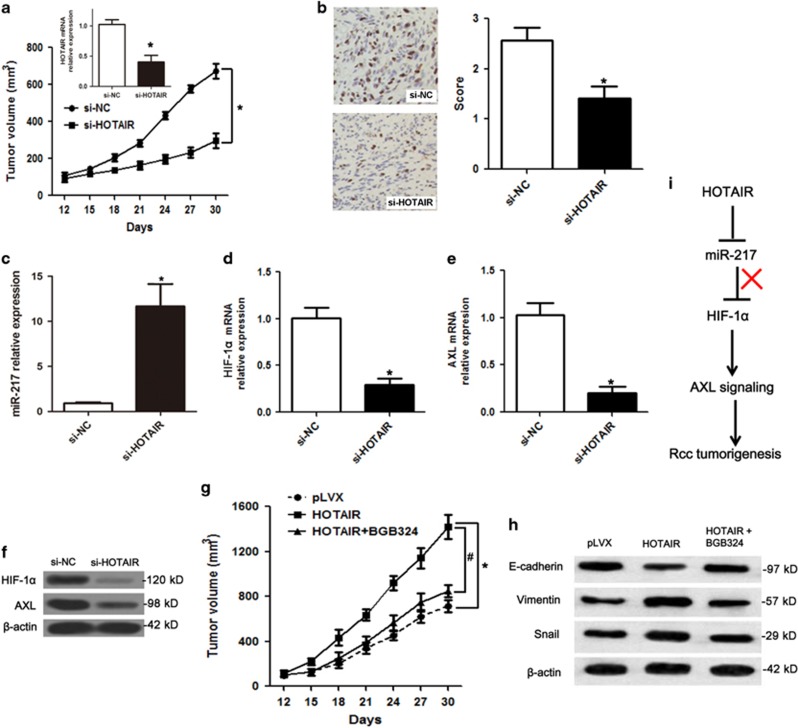
HOTAIR promotes Rcc cell growth via AXL signaling in vivo. (a) Tumor volume was evaluated for 12–30 days. The inset graph illustrates the efficiency of si-HOTAIR on HOTAIR expression. (b) Representative ki-67 staining (× 100). mRNA expression of miR-217 (c), HIF-1α (d), and AXL (e) in tumor tissues. Statistical analysis was conducted by unpaired Student’s t-test. *P<0.05 versus si-NC group (f) Western blot analysis for the protein levels of HIF-1α and AXL in tumor tissues. (g) Mice were subcutaneously injected with ACHN cells stably transfected with HOTAIR and orally administrated with BGB324 twice daily. Tumor volume was examined. (h) The expression of E-cadherin, Vimentin, and Snail was determined by Western blot. Data were analyzed using One-way ANOVA. n=6 per group, *P<0.05 versus pLVX group, #P<0.05 versus HOTAIR group. (i) Schematic of the proposed mechanism of HOTAIR in Rcc. HOTAIR functions as a ceRNA to ‘sponge’ miR-217 and upregulates the expression of HIF-1α as well as the HIF-1α downstream effector that promotes Rcc progression